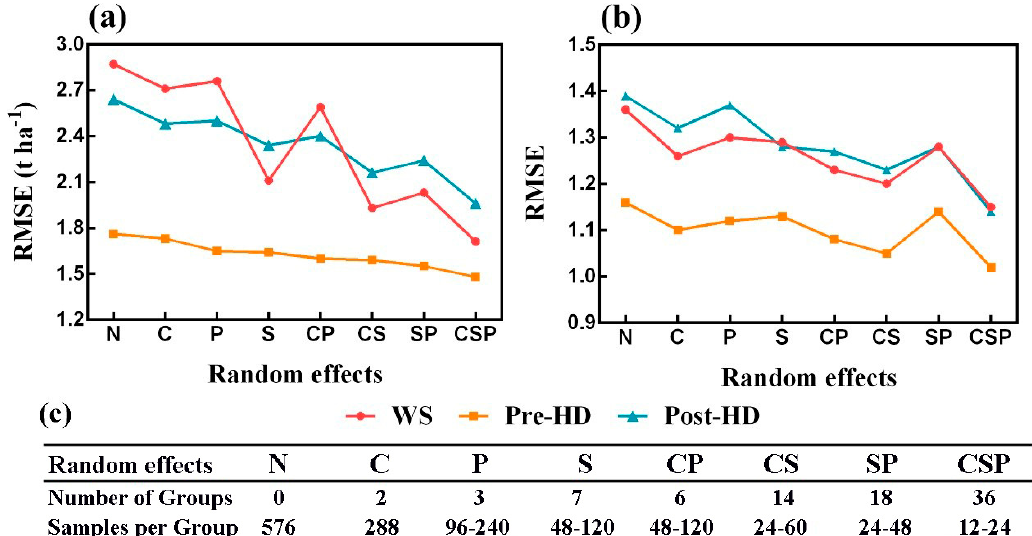
Figure 6. Determination of optimal model parameters (random effects) for linear mixed-effect (LME) model using RMSE: ( a ) AGB; ( b ) LAI; ( c ) grouping situation with different random effects. N represents no random effects (fixed effects only). C represents cultivar, P represents planting method, S represents growth stage, WS represents the whole season, Pre-HD represents pre-heading stages and Post-HD represents post-heading stages.